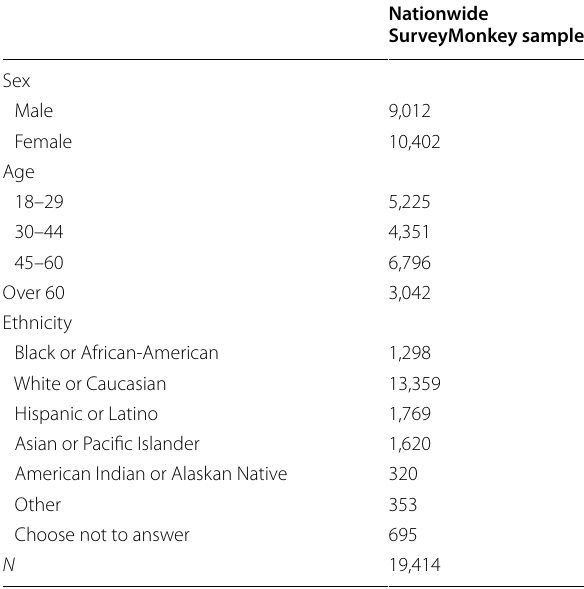
Table 4 Demographic information from our